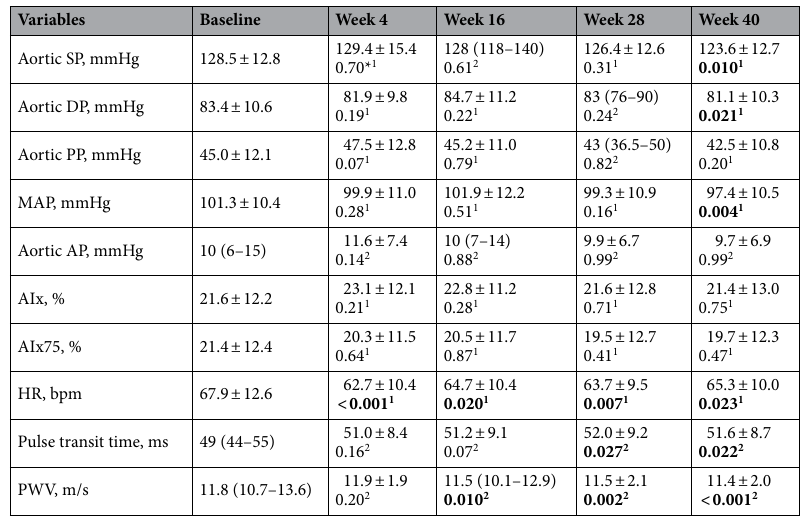
Table 2. PWV analysis at baseline, week 4, week 16, week 28, and week 40. SP systolic pressure, DP diastolic pressure, PP pulse pressure, MAP : mean arterial pressure, AP augmented pressure, AIx aortic augmentation comparison of baseline data with week 4, 16, 28 and 40. 1 Paired Student’s t-test. 2 Wilcoxon signed-rank test.